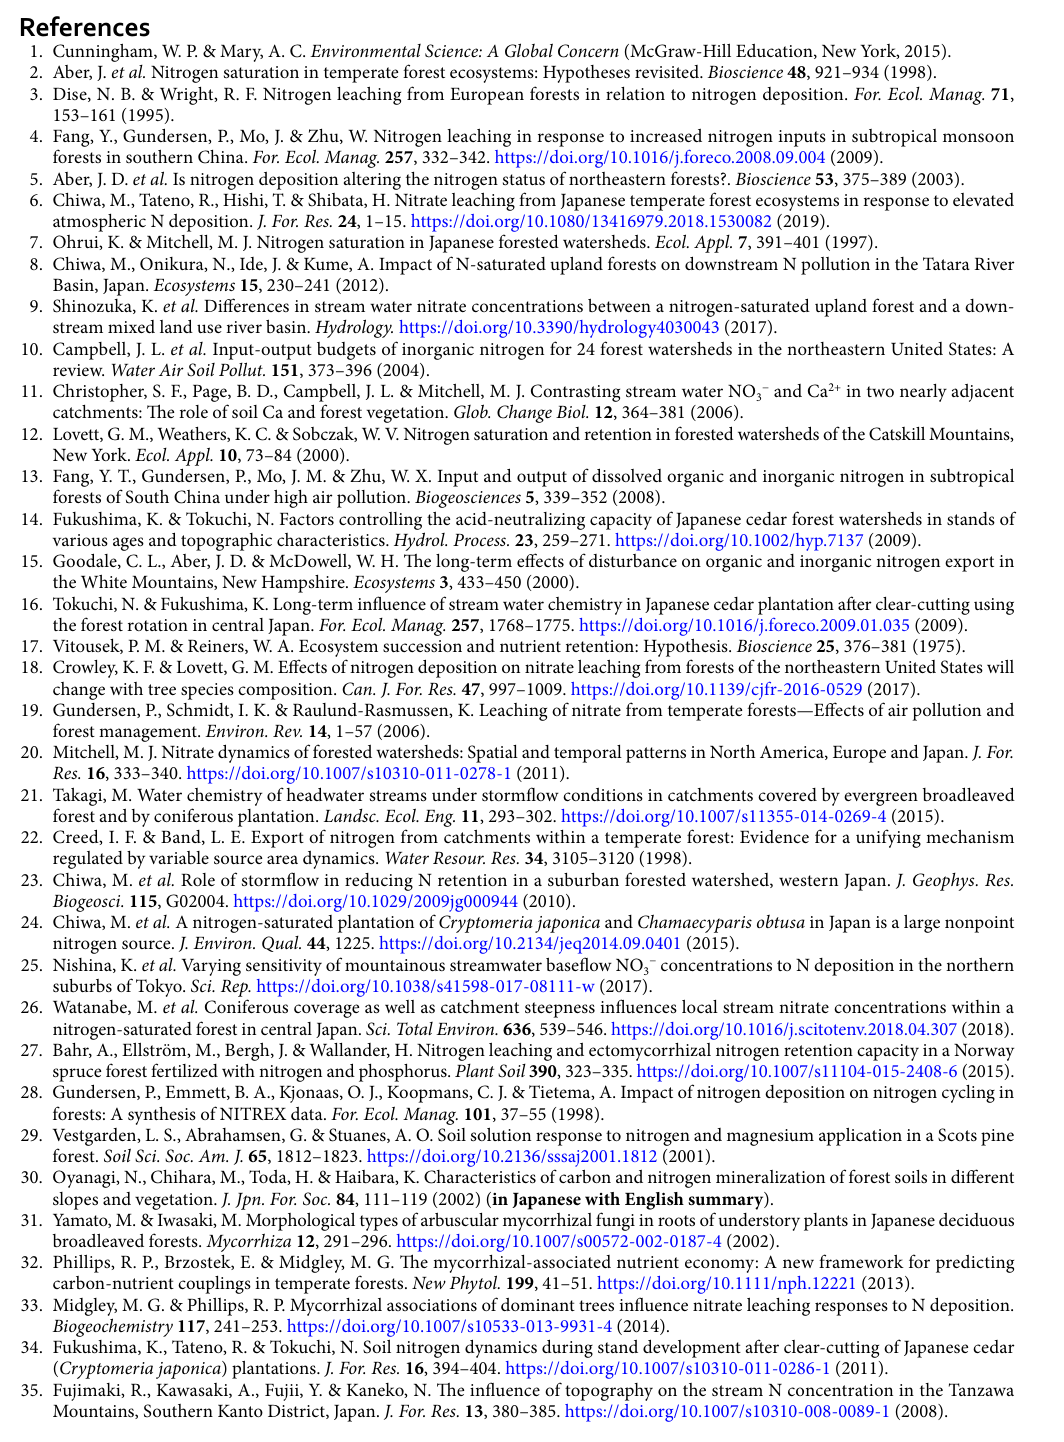
(°), respectively. Comparisons of soil chemical properties and N uptake between Japanese cedar and oak plan- tations were performed using t -tests. All the statistical analyses were performed using SPSS 22.0J (SPSS Japan Inc, Tokyo,